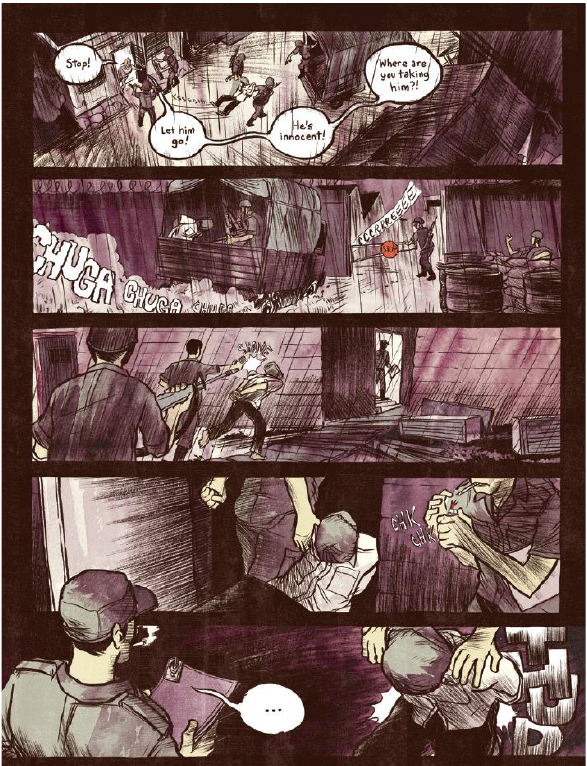
Figure 1: Tran, GB (2011) Vietnamerica (London: Villard,